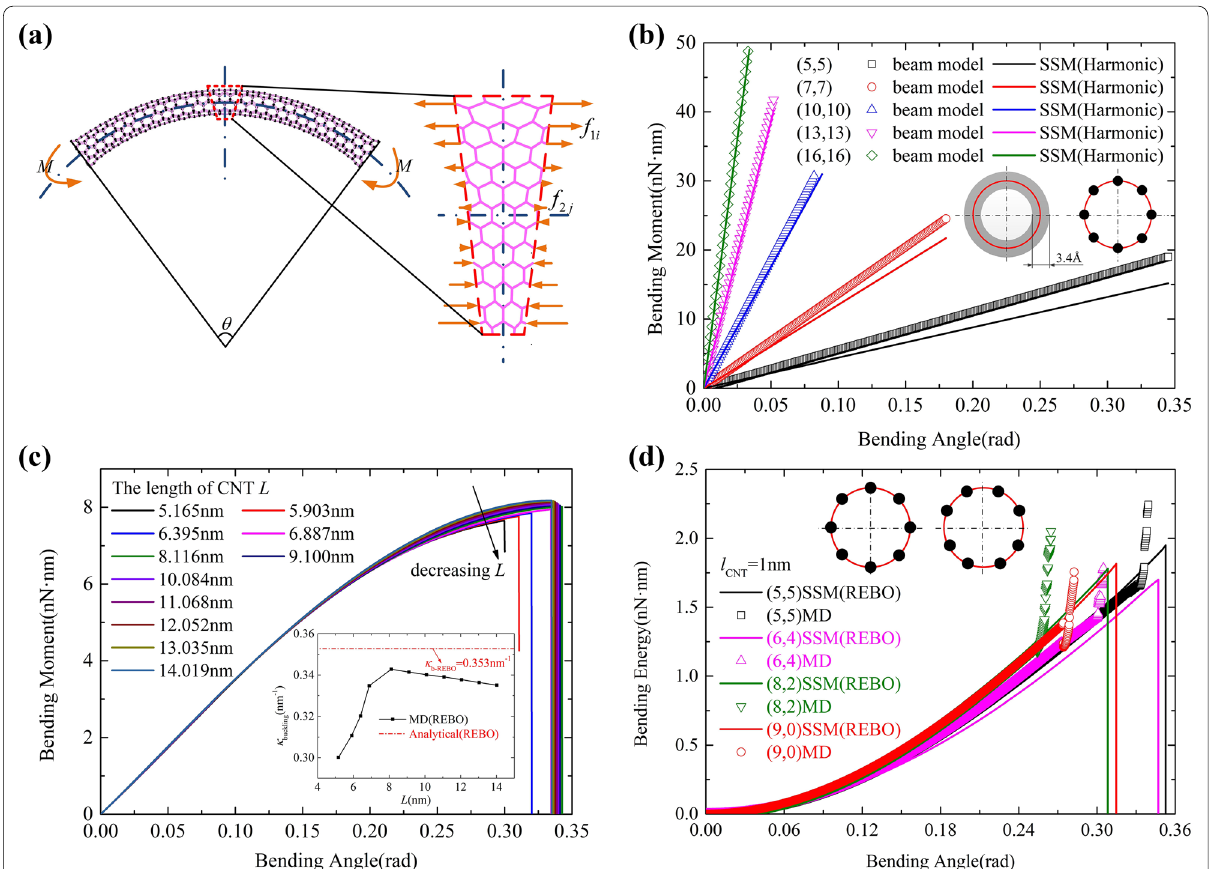
Figure 5 The bending behaviors of CNTs [61]: ( a ) Schematic diagram of a CNT under bending, ( b ) The distribution of bending moment for different CNT radii with bending angle, ( c ) The distribution of bending moment for different CNT lengths with bending angle, and the inset represents the critical buckling curvature with L, ( d ) The distribution of the bending energy per unit length for different chiral CNTs with bending